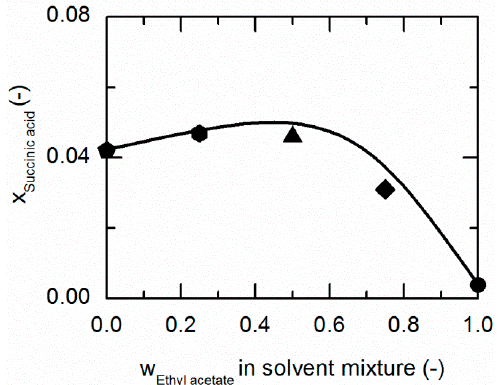
Figure 4. Solubility of succinic acid (SA) in ethanol/ethyl acetate mixtures at 298.15 K. The line correspond to the PC-SAFT correlation; symbols represent the experimental data points for SA in ethanol (pentagon), in the ethanol/ethyl acetate (solute-free) mixtures 0.75/0.25 w / w (hexagon), 0.5/0.5 w / w (up-pointing triangle), 0.25/0.75 w / w (diamond), and in ethyl acetate (circle).